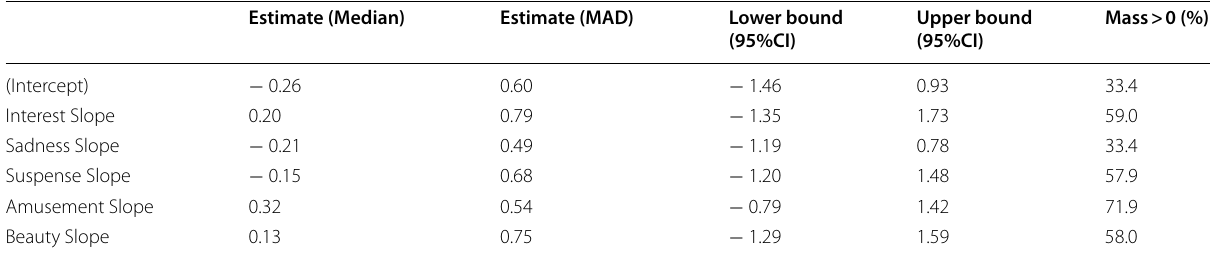
The median, median absolute difference, 95%CI and mass > 0 of the posterior distribution are